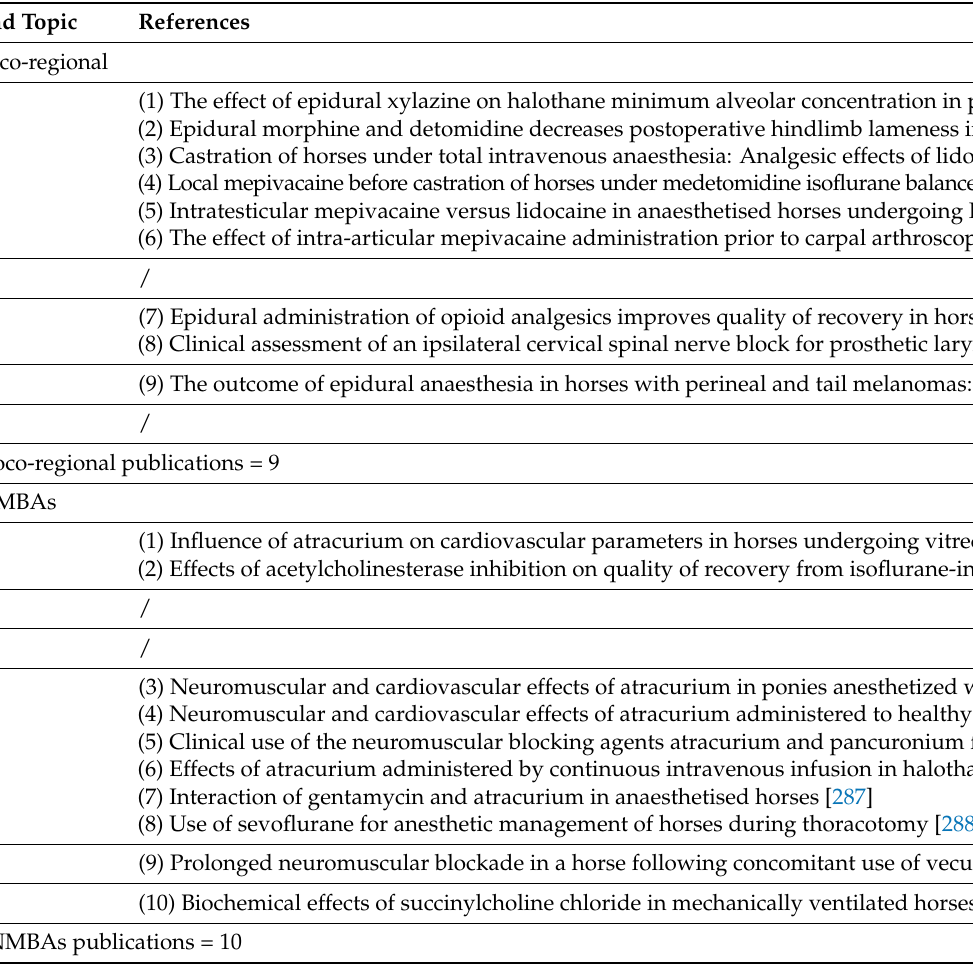
Table 7. Total of publications giving information about effects on the recovery phase of: (7a) “ loco-regional ”, (7b) “ neuromuscular blocking agents (NMBAs) ” and (7c) “ other drugs ” given during the maintenance of general